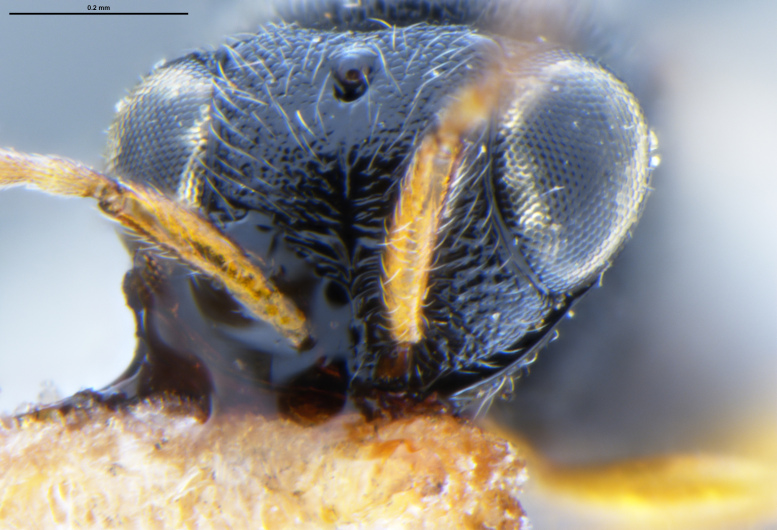
head, anterior view